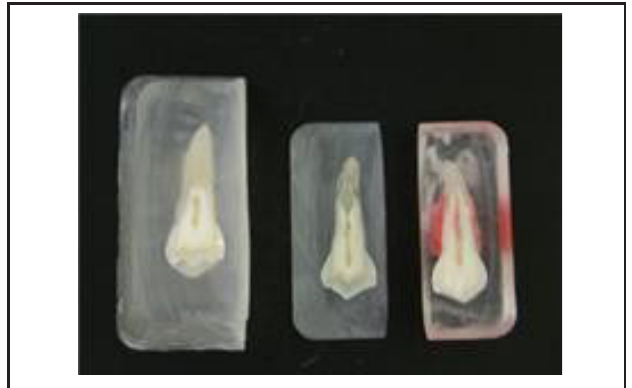
Fig. 4 – Resin block sectioned with the tooth 1-mm-thick cut central